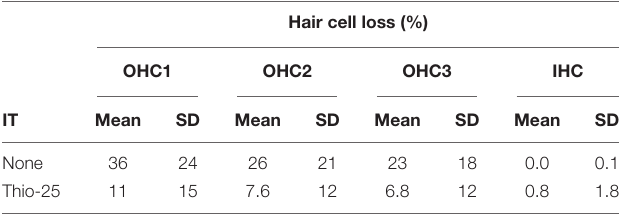
TABLE 3 | Quantification of hair cell loss in Thio-25-cispt group described in Figure 2 .